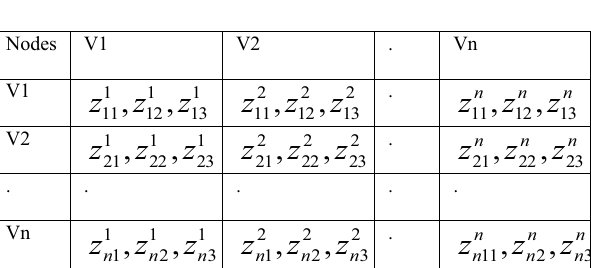
Table: 3 contain QoS values of the all sensor node with all possible cluster heads.